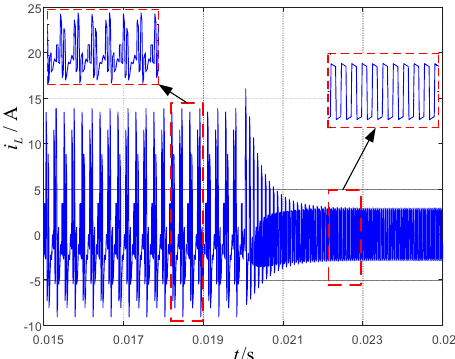
Figure 11. Inductor current before and after activating the predictive module.